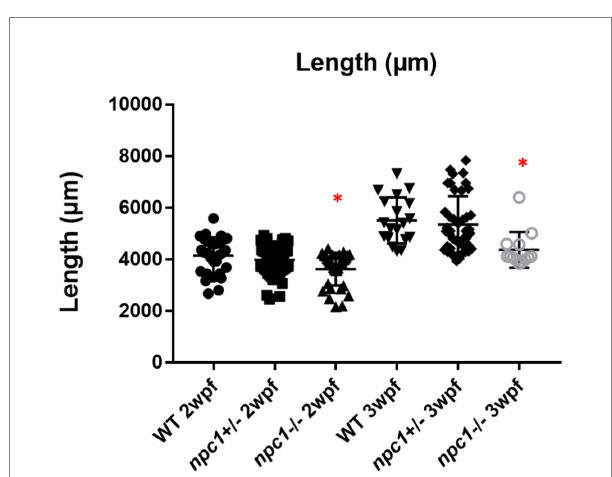
FIGURE 3 Shorter body length in npc1 − / − from 2 wpf compared with wt and npc1 +/ − (value of p <0.05). We compared the fish that had the same age: the 3 groups of 2 wpf and the 3 groups of 3 wpf. Statistically significant data in the graphs is indicated with a red